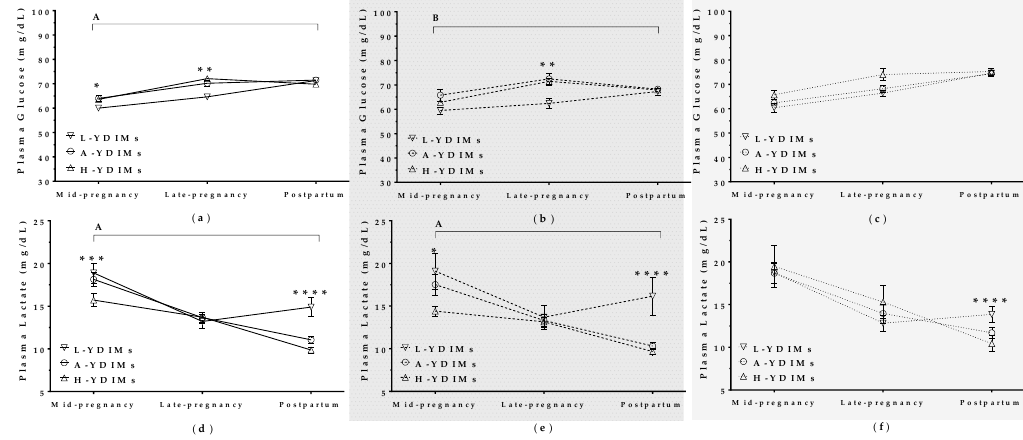
Figure 6. Plasma glucose levels in ( a ) all ewes, ( b ) mature ewes, and ( c ) maiden sheep showing high, average, or low milk yield at different stages of pregnancy and the postpartum period. Lactate levels in ( d ) all ewes, ( e ) mature ewes, and ( f ) maiden sheep showing high, average, or low milk yield at different stages of pregnancy and the postpartum period. L-YDIM: low-yielding sheep with a TMY (total Milk Yield) <220L/lactation; A-TMY: average yielding sheep (220 – 371 L); H-TMY: high-yielding sheep (>371 L). Data are mean ± SEM. Significant interactions between pregnancy/postpartum stage and YDIMs are represented by an upper horizontal line (A: p < 0.0001; B: p < 0.05). Asterisks indicate significant differences between groups at each time point (**** p < 0.0001; *** p < 0.001; ** p < 0.01; * p < 0.05).